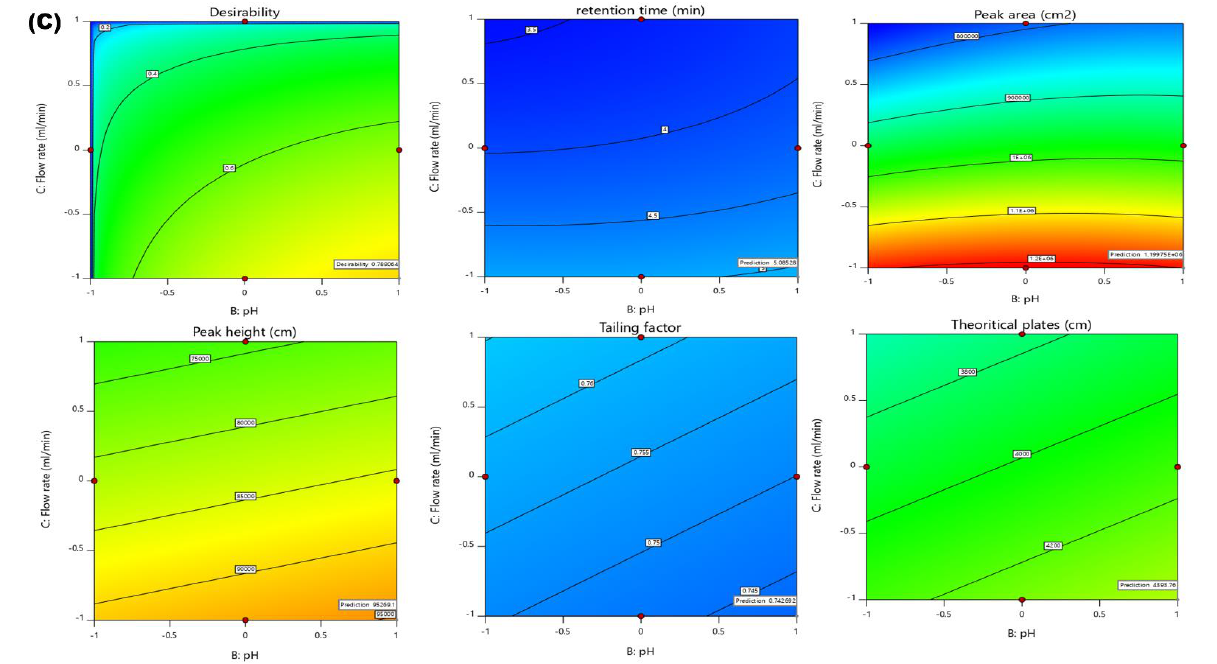
Figure 4. Optimized numerical 2D-Contour plots representing the optimal solutions and desirability of dependent variables; Retention time (R1), Peak area (R2), Peak height (R3), Tailing factor (R4), and Theoretical plates (R5). ( A ) Effect of the mobile phase ratio (A) and pH (B), ( B ) Effect of mobile phase ratio (A) and Flow rate (C), ( C ) pH (B), Flow rate (C).